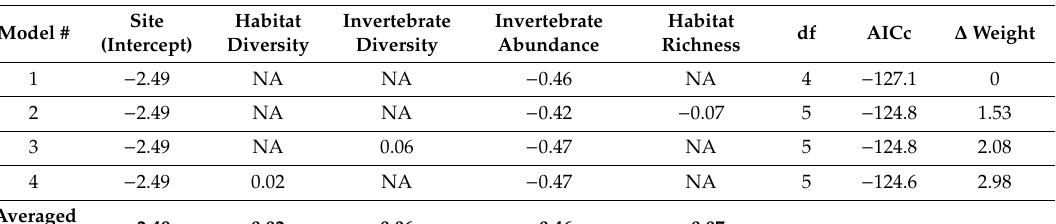
Table 2. List of variables included, regression coe ffi cients, degrees of freedom (df) and Akaike’s Information Criteria corrected for small sample size (AICc), for all candidate models and averaged final model for each of the response variables within the path analysis. ( a ) Epiphyte load, ( b ) invertebrate abundance and ( c ) invertebrate diversity (H (cid:48)